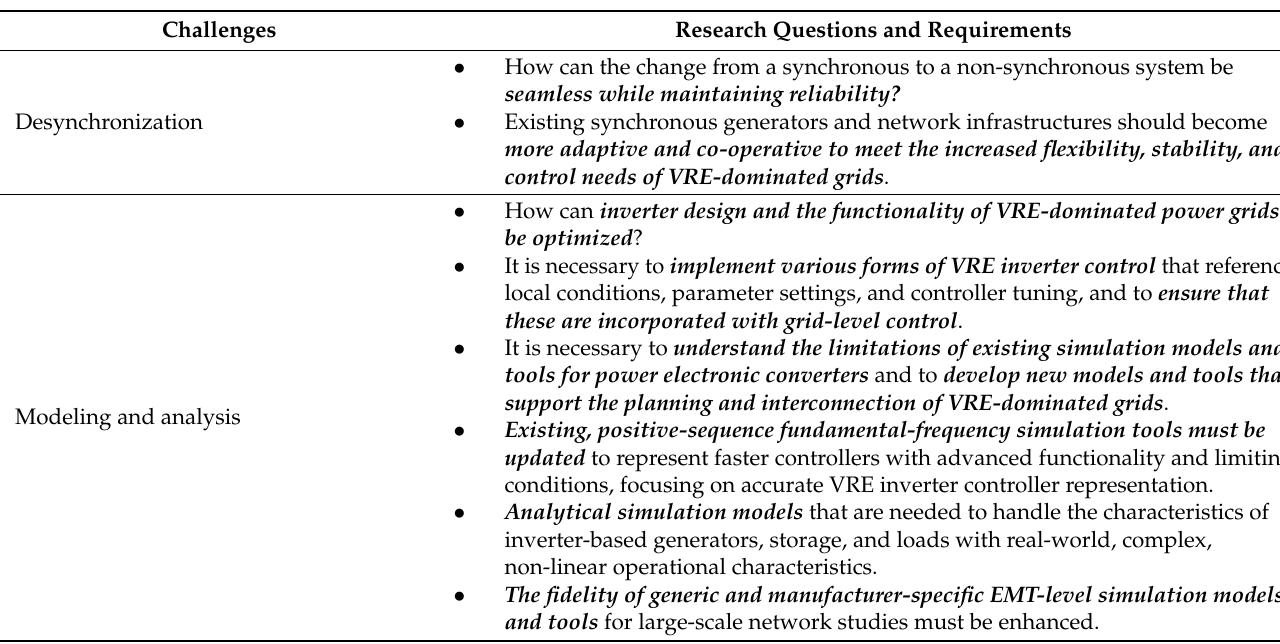
Table 2. List of research challenges in VRE inverter